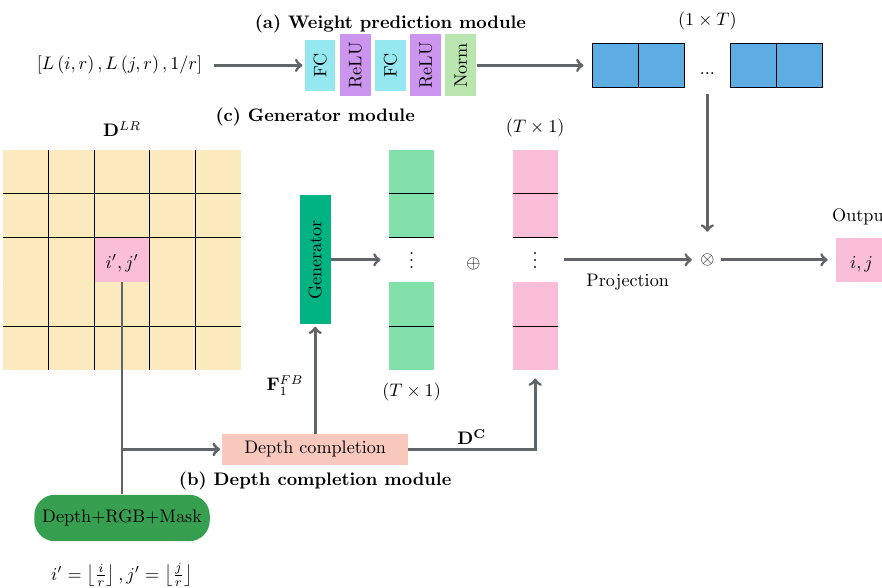
Figure 1. The architecture of the proposed networks for depth completion and depth super-resolution with arbitrary scale factors. This figure depicts the process used to synthesize the output at location i , j in the SR depth map: ( a ) the Weight Prediction Module; ( b ) the Depth Completion Module; and ( c ) the Generator Module. Note that and represent the elementwise summation of two matrices ⊕ ⊗ and matrix multiplication,